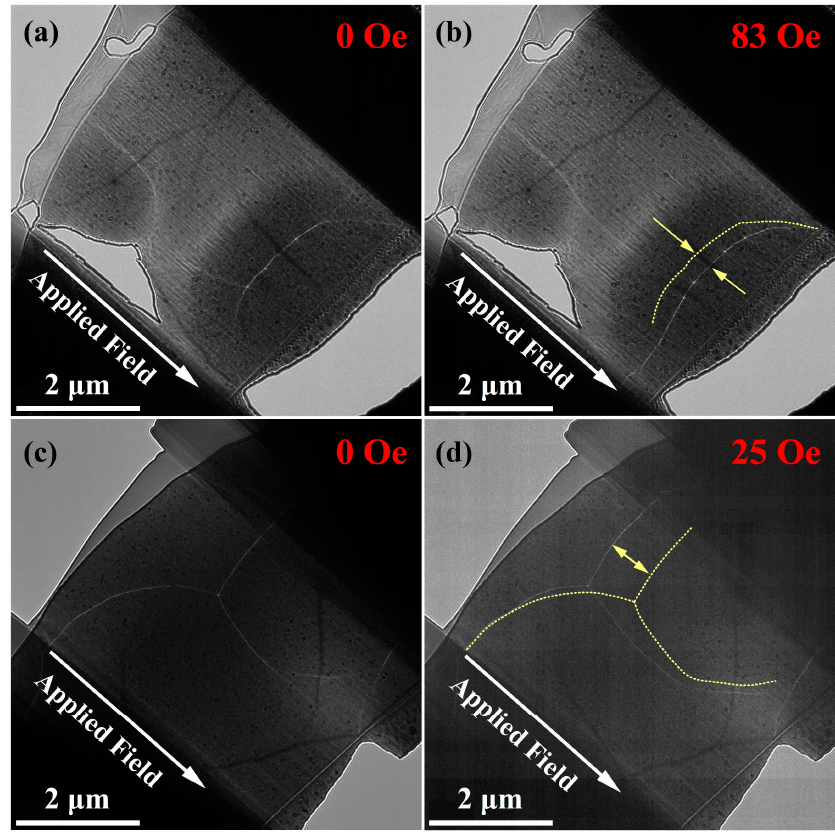
Figure 9. LTEM images for the field dependence of domain wall evolution in Fe 74.75 Si 8 B 10 P 3 C 2 Nb 1.5 Cu 0.75 NPCs annealed under different conditions: ( a , b ) 40 K/min, 60 min; ( c , d ) 100 K/min, 30 min.